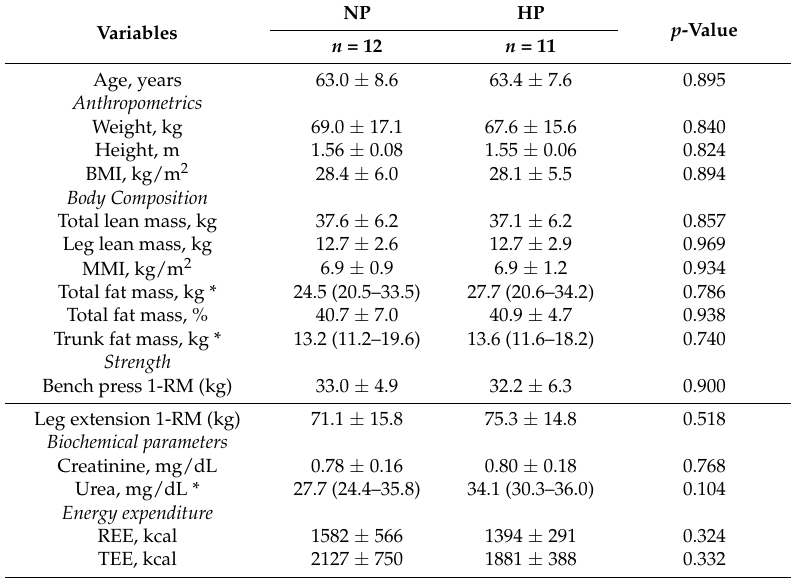
Table 1. Baseline characteristics of the participants in the